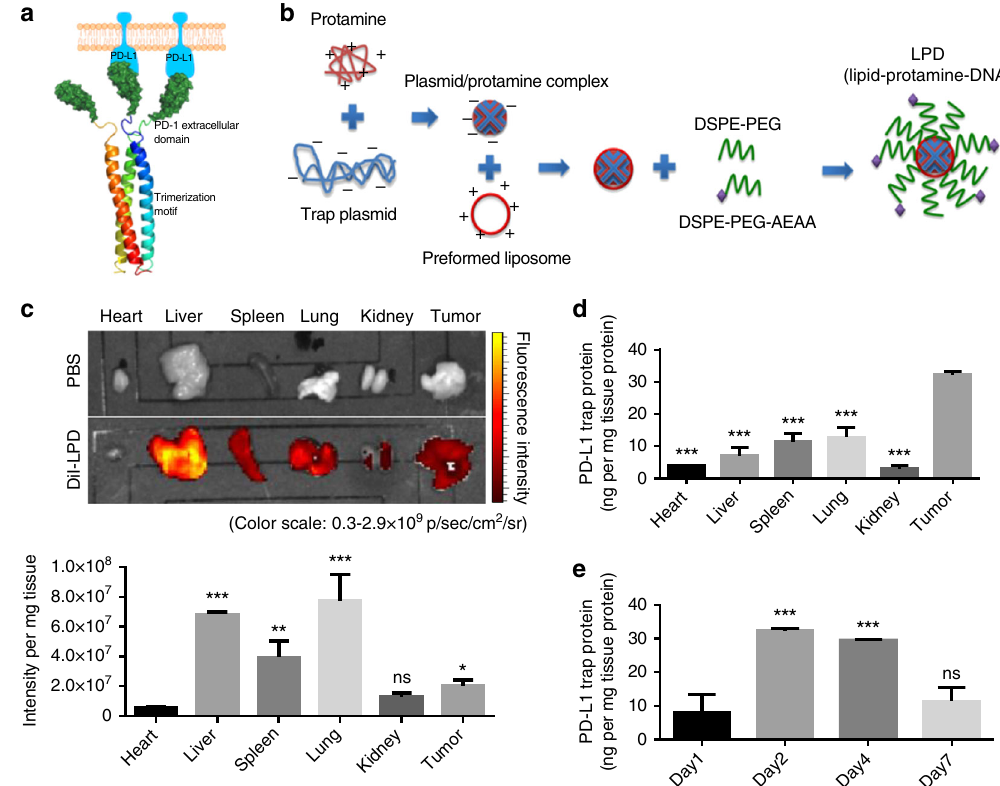
Fig. 4 Design of locally and transiently expressed PD-L1 trap. a Scheme showing the tribody interaction of PD-L1 trap protein. b Preparation scheme of PD-L1 trap plasmid loaded LPD. c Images and quantitative results of the DiI-loaded LPD in major organs and the CT26-FL3 tumor at 24h after injection ( n = 3). d PD- L1 trap protein expression in major organs and the CT26-FL3 tumor at 48h after injection. The PD-L1 trap expression was measured using ELISA by targeting the His (6×)-tag engineered at the C-terminus of the PD-L1 trap ( n = 3). e PD-L1 trap protein expression in tumors on days 1, 2, 4 and 7 after injection. Signi fi cant differences in c , d , and e were assessed using t test. Results are presented as mean (SD). ns, not signi fi cant. * P <0.05, ** P <0.01, *** P